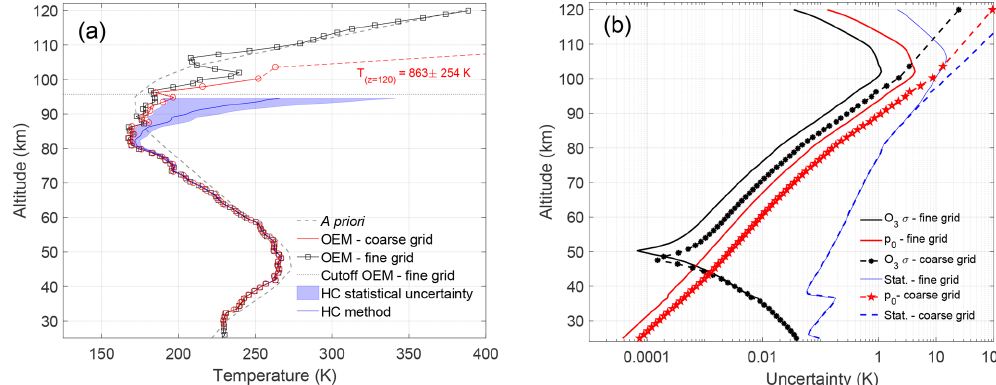
Figure 17. (a) PCL temperature retrieval for the fine and coarse grids on 12 May 2012. The temperature and its uncertainty for the last coarse-grid point has a large value and it is not shown. (b) The statistical and systematic uncertainties due to the tie-on pressure and ozone cross section for the PCL temperature retrieval. The other systematic uncertainty terms included in our retrieval are not shown.